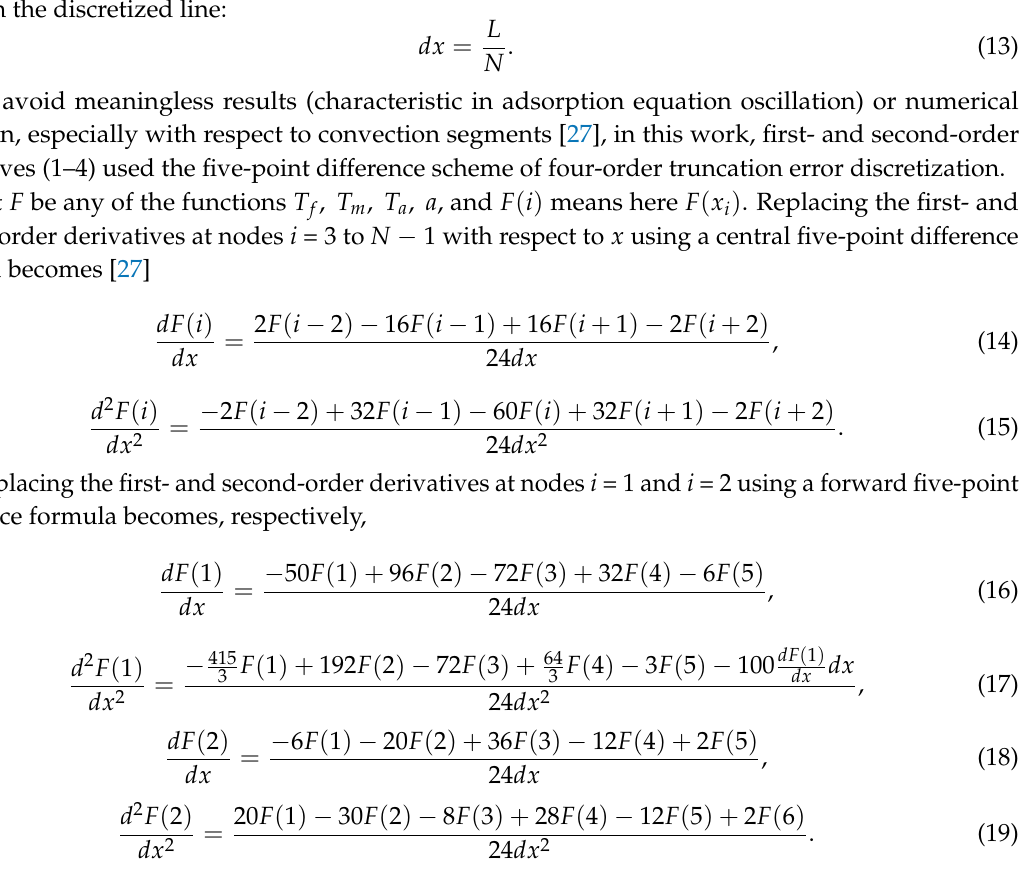
Figure 3. Illustration of adsorber discretization in the x -direction (numerical method of lines, NMOL).